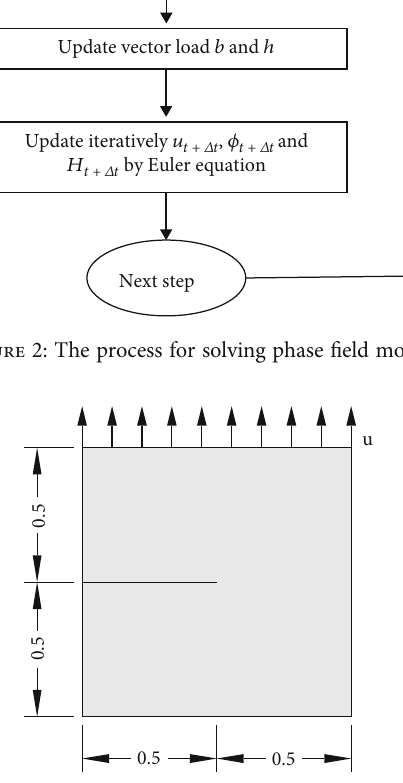
Figure 3: Geometric model and the location of crack